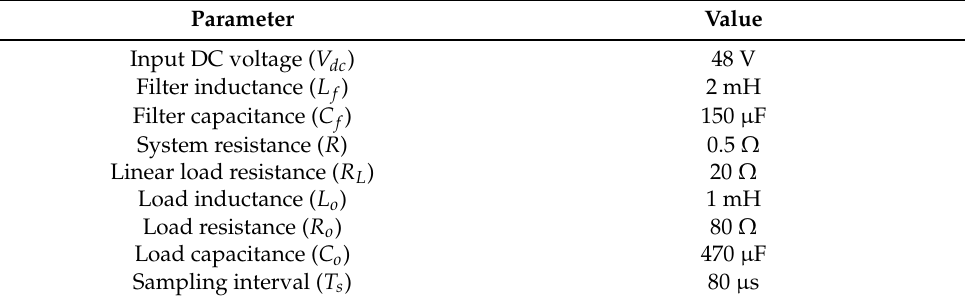
Table 1. System electrical parameters and control